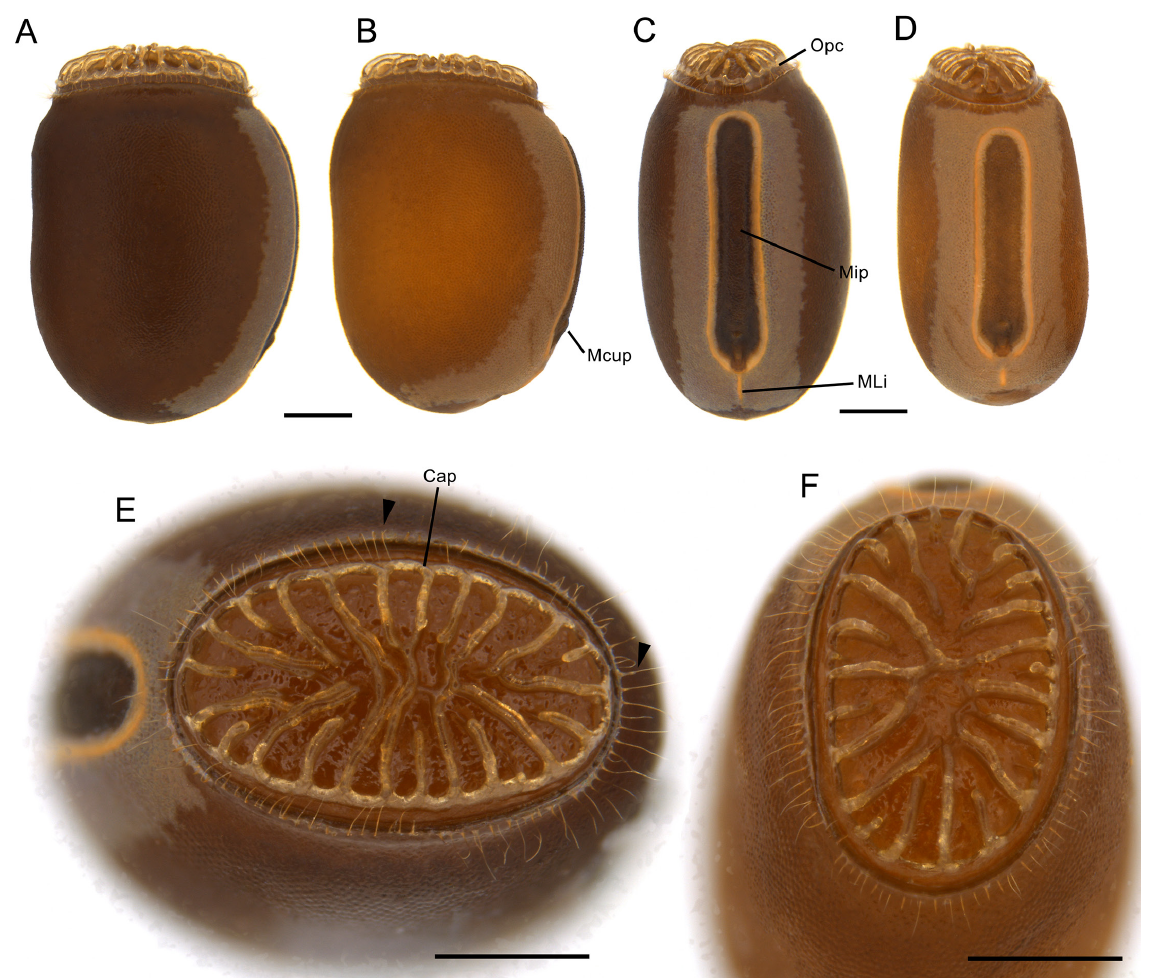
Fig. 42. Arumatia motenata Ghirotto gen. et sp. nov., egg morphology. A–B . Lateral view. C–D . Dorsal view. E–F . Detail of operculum, anterior view, arrowheads pointing to bristles on opercular collar (E). Abbreviations: Cap = capitulum; Mcup = micropylar cup; Mip = micropylar plate; MLi = median line; Opc = operculum. Scale bars: 0.5